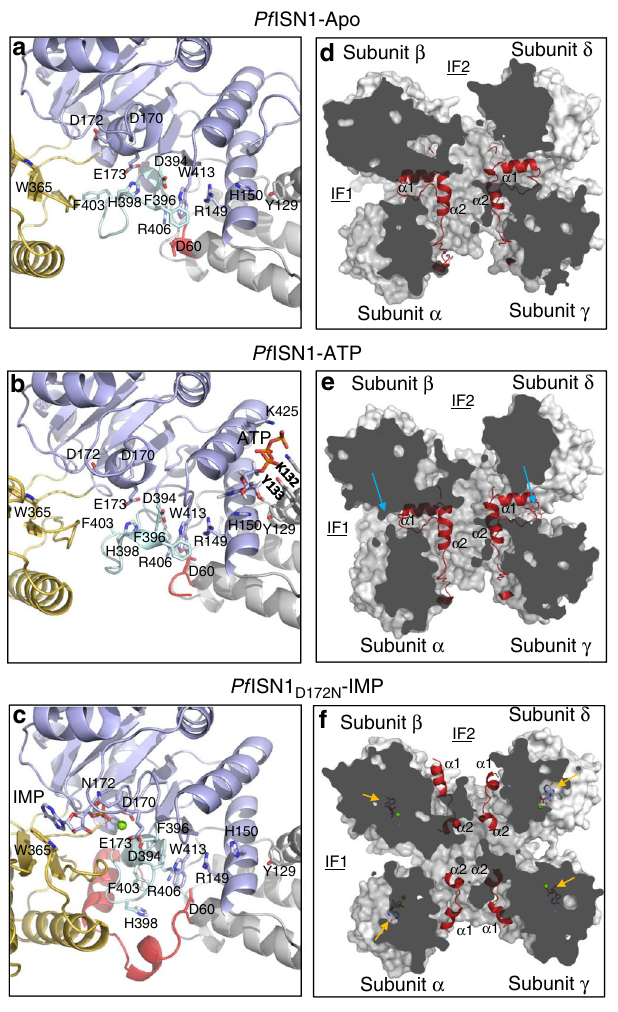
Fig. 5 Reorientation of the NTRD. a , d From apo- to b , e ATP-bound- and to c , f IMP-bound conformations. Blue arrows indicate the ATP-binding site, and yellow arrows the IMP-binding site. Mg 2 + is depicted as a green sphere in ( c ) and ( f ). IF1 interface 1. IF2 interface